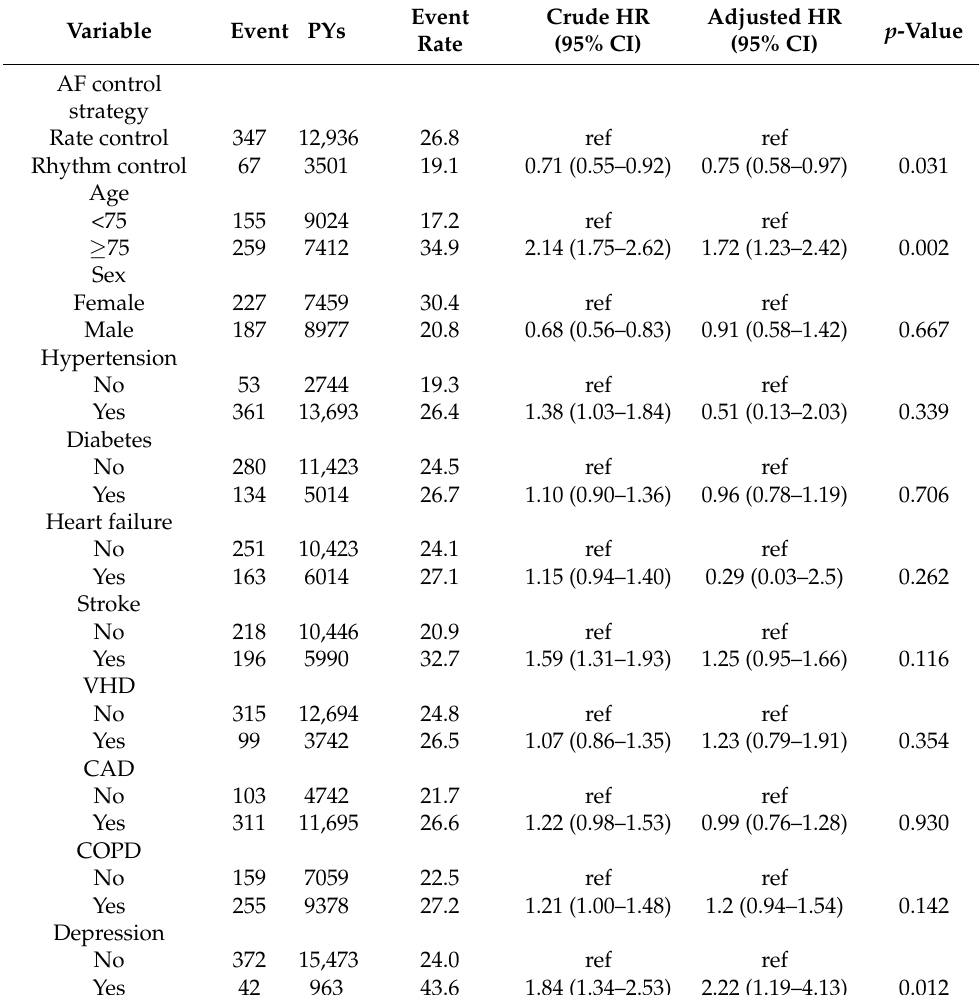
Table 3. Factors and the hazard ratio for dementia in AF